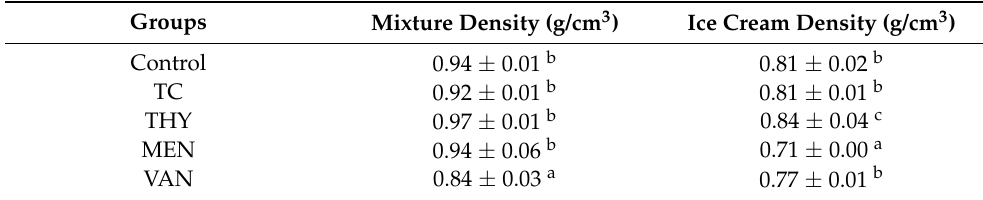
Table 2. Density results of TC, THY, MEN or VAN egg yolk ice creams in mixtures and after ice cream process.